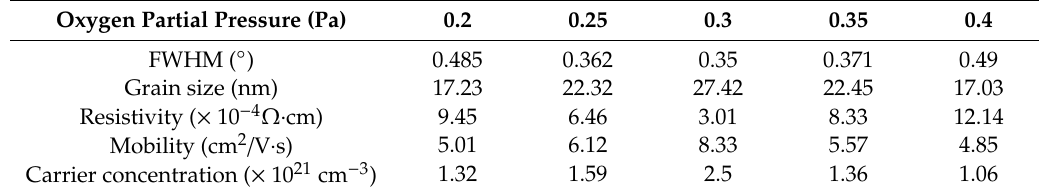
Table 5. The performances of ZnO:Ga films produced at different oxygen partial pressures [75]. Oxygen Partial Pressure